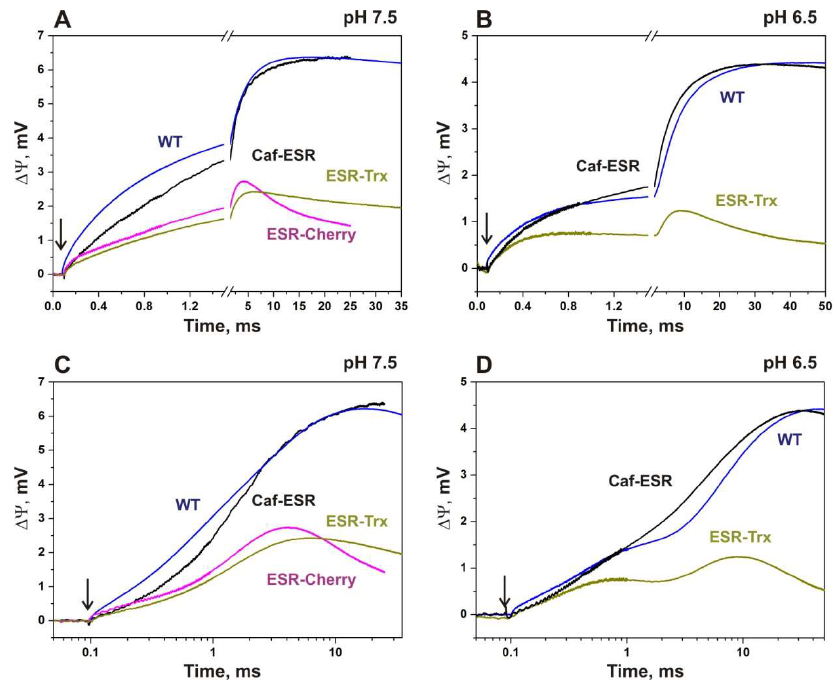
Figure 5. Kinetics of light-induced changes in membrane potential difference, ΔΨ, in proteoliposomes containing wild-type ESR and hybrid proteins at pH 7.5 ( A , C ) and 6.5 ( B , D ). Photoelectric traces are shown on a piecewise linear ( A , B ) and logarithmic ( C , D ) time scale. The trace of the wild-type ESR is normalized by the maximum amplitude with that of the Caf-ESR. For the ESR-Cherry, only the trace of photoelectric response at pH 7.5 is shown. The time point of the flash is indicated by an arrow. After the flash, all three hybrid proteins produced a photoelectric response, which corresponded to the proton transfer from the inside of the liposomes to the bulk, similar to the wild-type ESR [35]. However, the amplitude of ΔΨ generated by the proteolipo- somes with ESR-Cherry and ESR-Trx was on average about two times smaller than that of the proteoliposomes with Caf-ESR under the same conditions (Figure 5). Moreover, the number and sign of the components and the rate constants of the electrogenic response exhibited substantial differences between these proteins as discussed below.